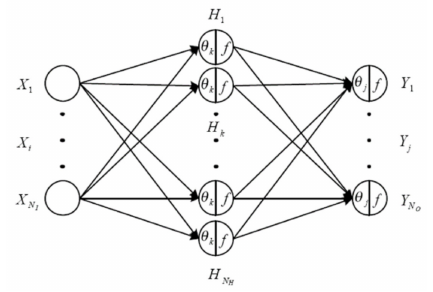
Figure 1. Illustration of